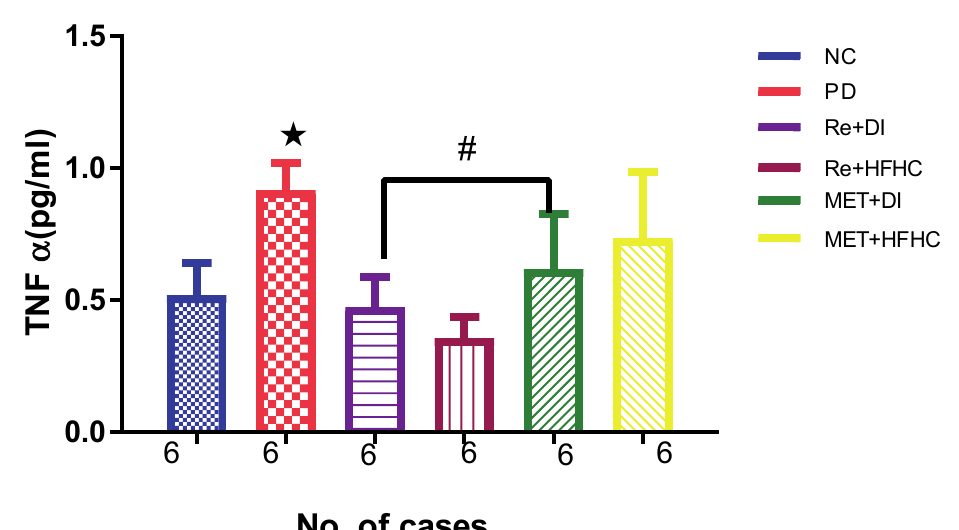
Figure 6. TNF α in normal control (NC), prediabetic control (PD), metformin and diet intervention (MET + DI), metformin and high-fat/high-carbohydrate diet (MET + HFHC), rhenium (V) com/pound and diet intervention (Re + DI), and rhenium (V) compound and high-fat/high-carbo- hydrate diet (Re + HFHC) groups after 12 weeks of treatment. Values are presented as means ± SEM (n = 6).